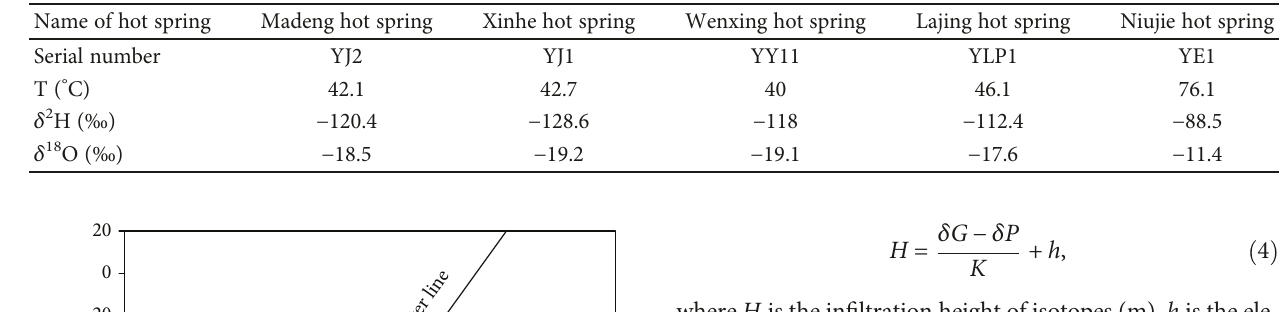
Table 2: Data of δ 2 H and δ 18 O of the hot spring water